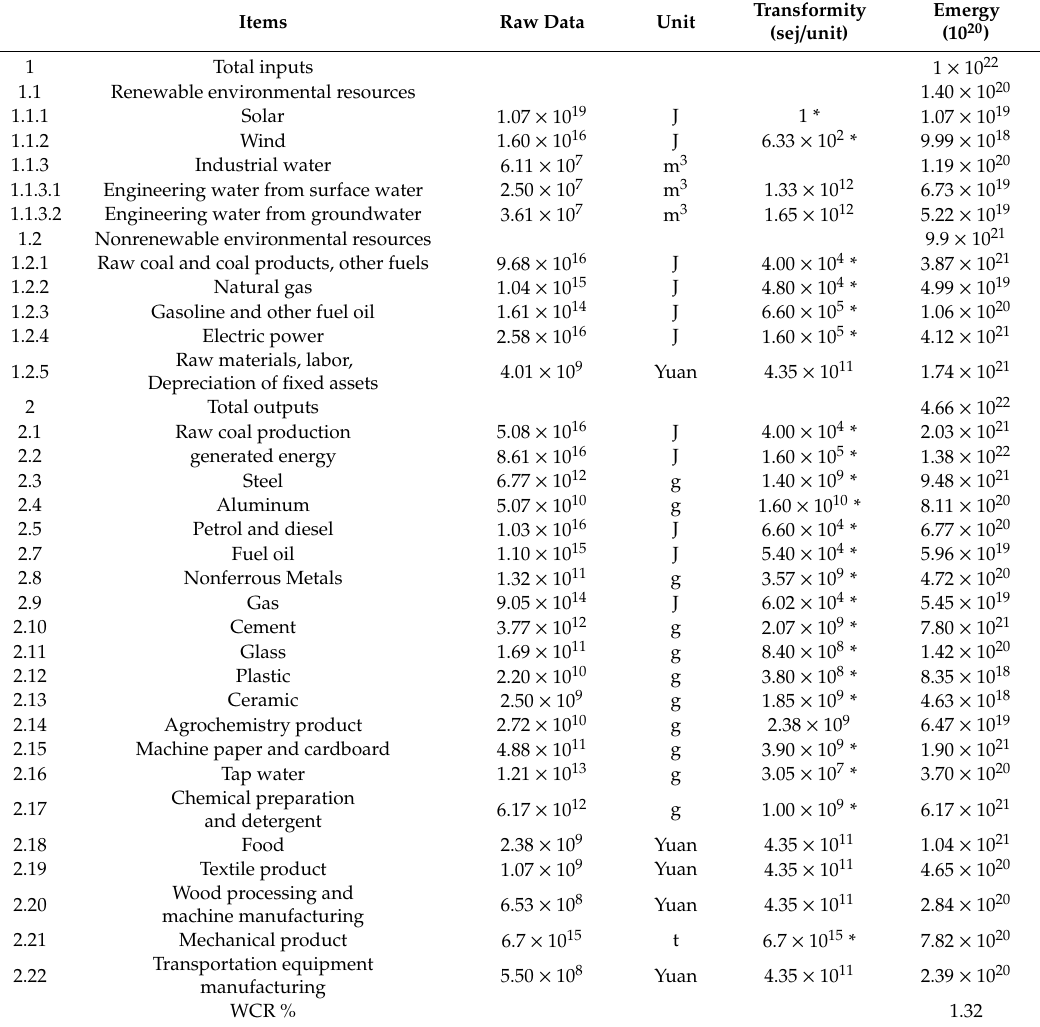
Table 4. Emergy inputs and outputs within and outside Jiyuan industrial